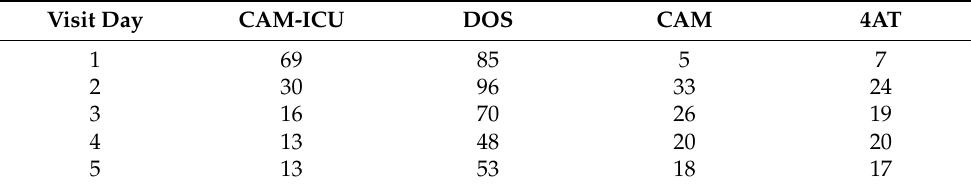
Table 4. Positive POD tests per visit day.